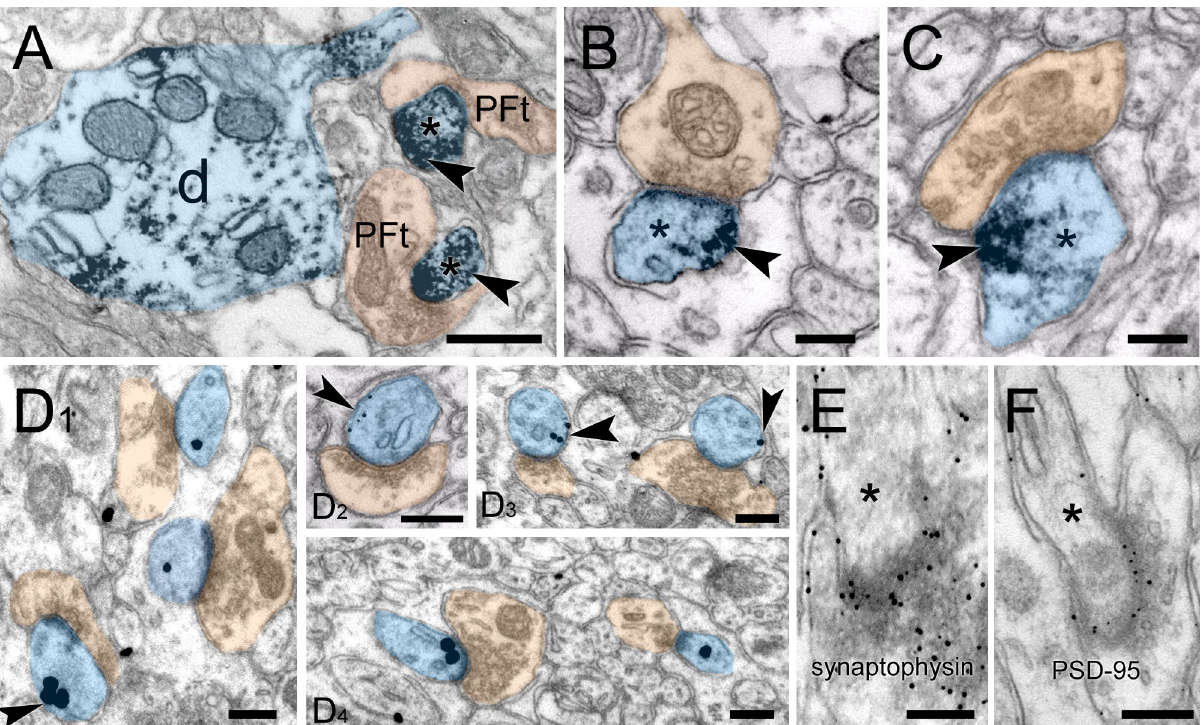
Figure 4. Immune-electronmicroscopy of cortactin in spines of distal PC branchlets. (A–C) Robust postsynaptic DAB reaction product (blue pseudo-color) in Purkinje-cell dendrites (d), and spines (*) (parallel fiber terminals (PFt) seen in orange pseudo-color). Arrowheads point to accumulated patches of immunoperoxidase reaction product at submembrane regions. ( D 1–4 ) Immunogold label coding for cortactin. Dendritic spines of PCs (blue pseudo-color); cortactin-coding immunogold particles may be seen in the periphery of spines associated with synaptic membranes, non-synaptic membranes, and submembrane spinoplasm (arrowheads). ( E,F) Immunogold particles coding for synaptophysin ( E ) may be seen labelling presynaptic terminals. In contrast, PSD-95 ( F ) label is restricted to the postsynaptic density of PC spines. Scale bar: (A) : 500 nm, and (B–F) : 250 nm.